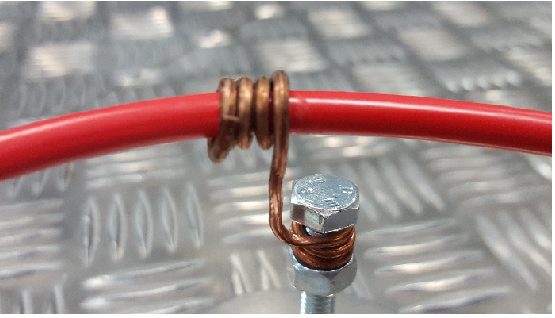
Figure 4. Detail of the section of the high voltage cable (in red) with the wound wire to ground.